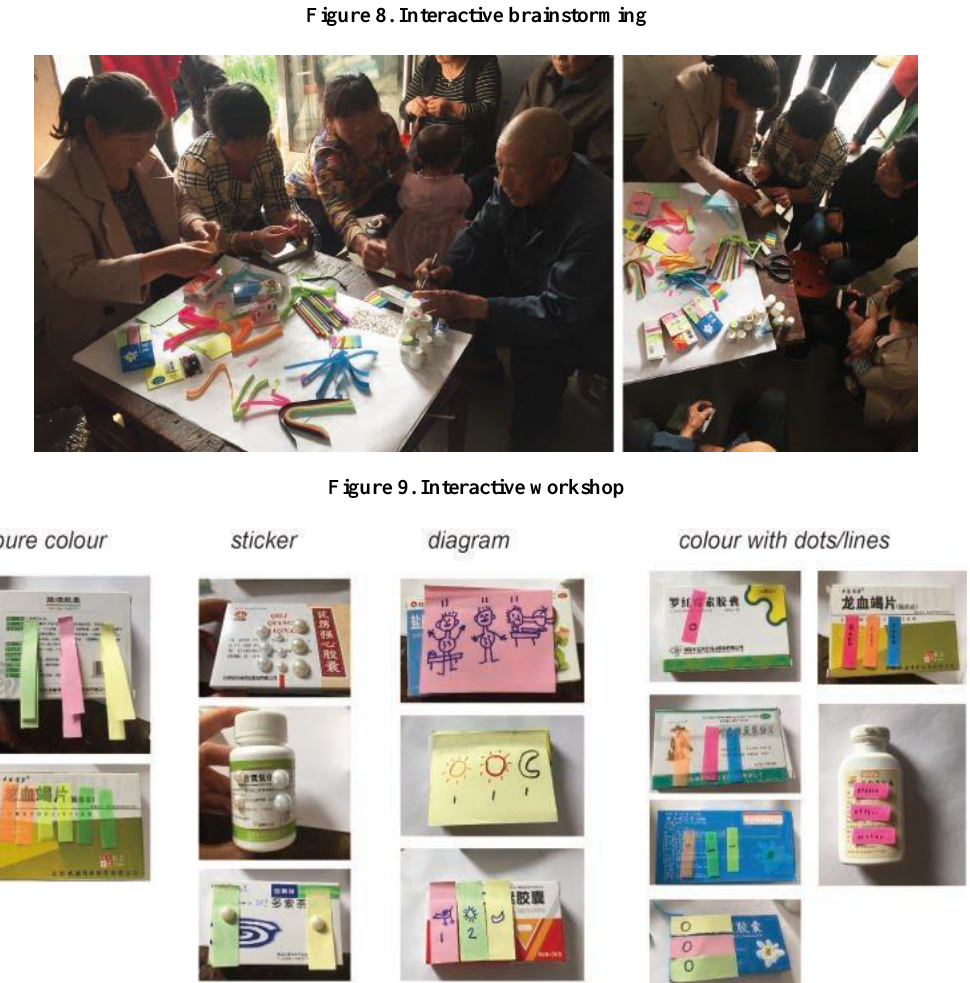
Figure 10. Results of the